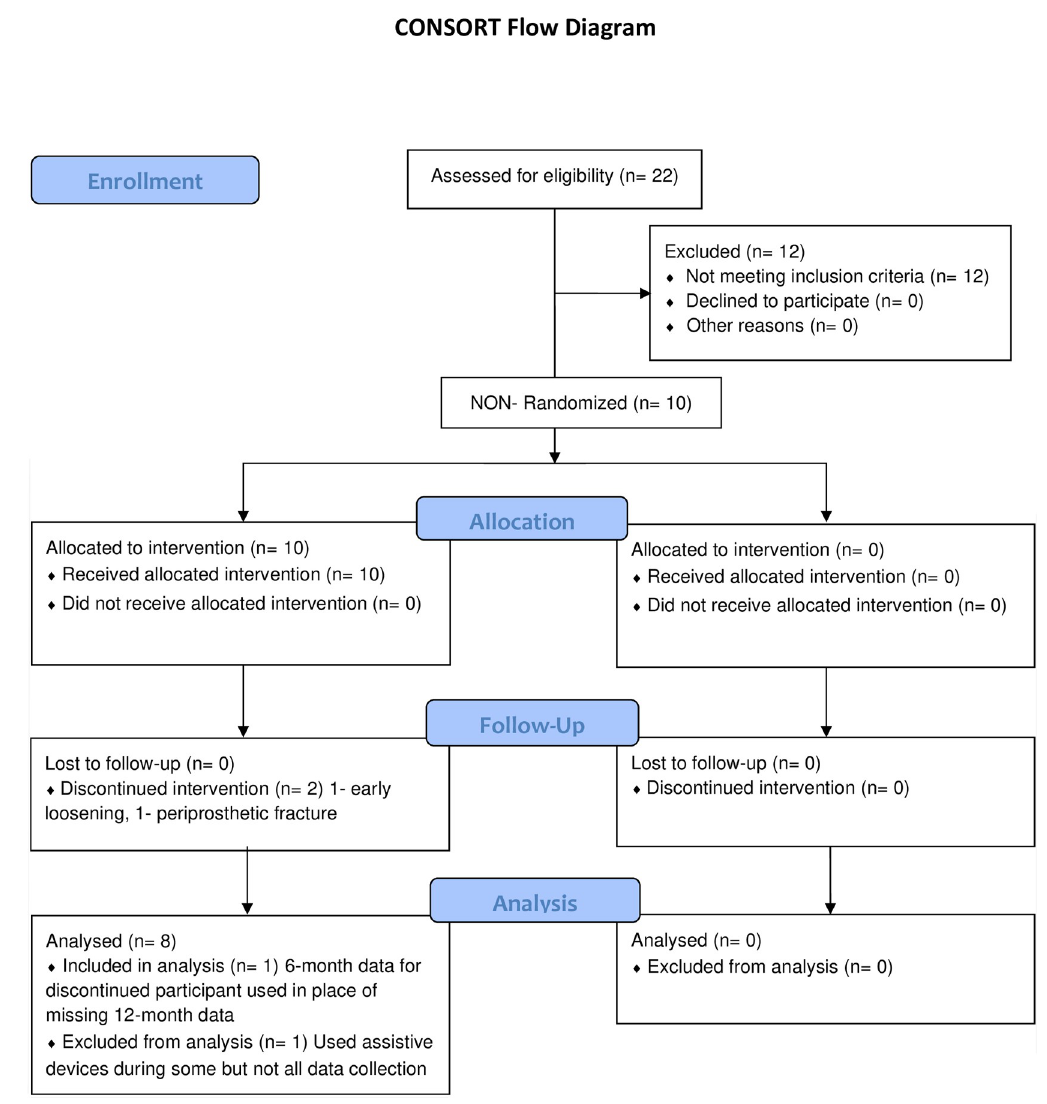
Fig 1. CONSORT flow